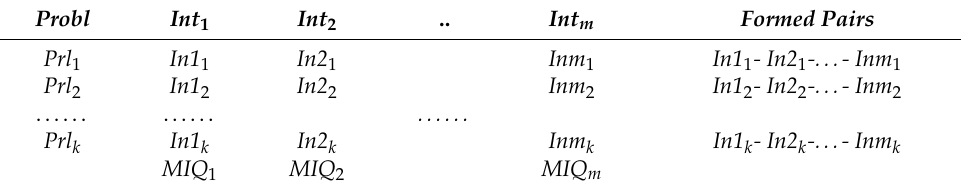
Table 1. Results of the problem-solving intelligence